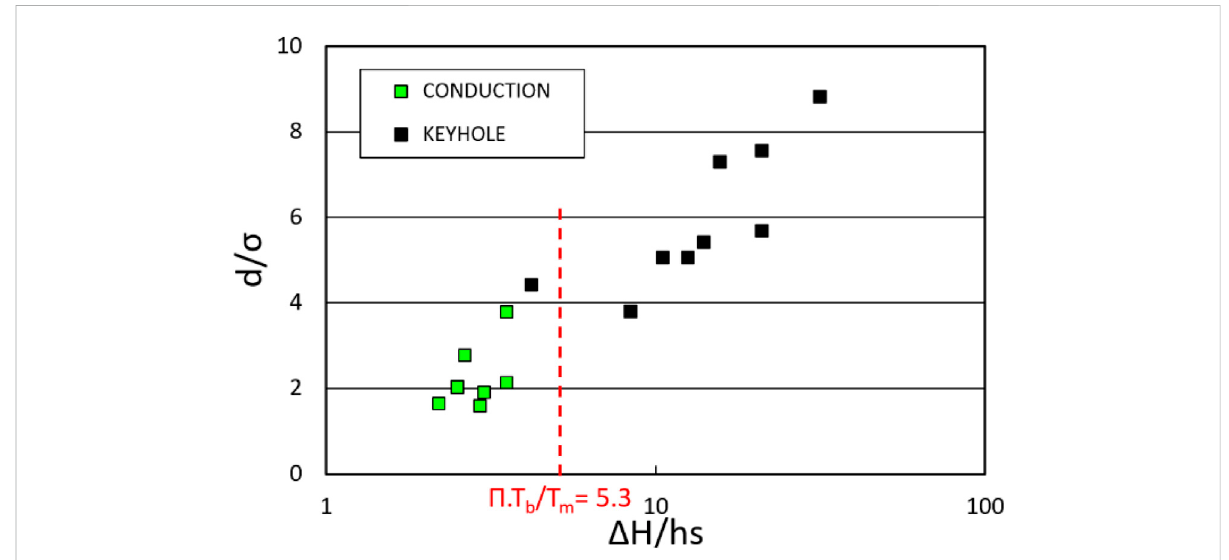
FIGURE 7 Melting regime transition between conduction and keyhole mode for LPBF processed Bi 2 Te 3 .